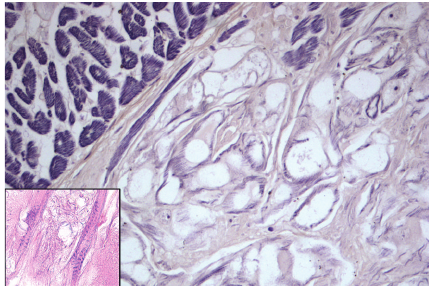
Figure 4: Heart; bearded seal. Normal myocardium and some rhabdomyoma cells are positive for PTAH. Striations (insert) are more common in normal cardiomyocytes but are occasionally observed in neoplastic cells. PTAH.